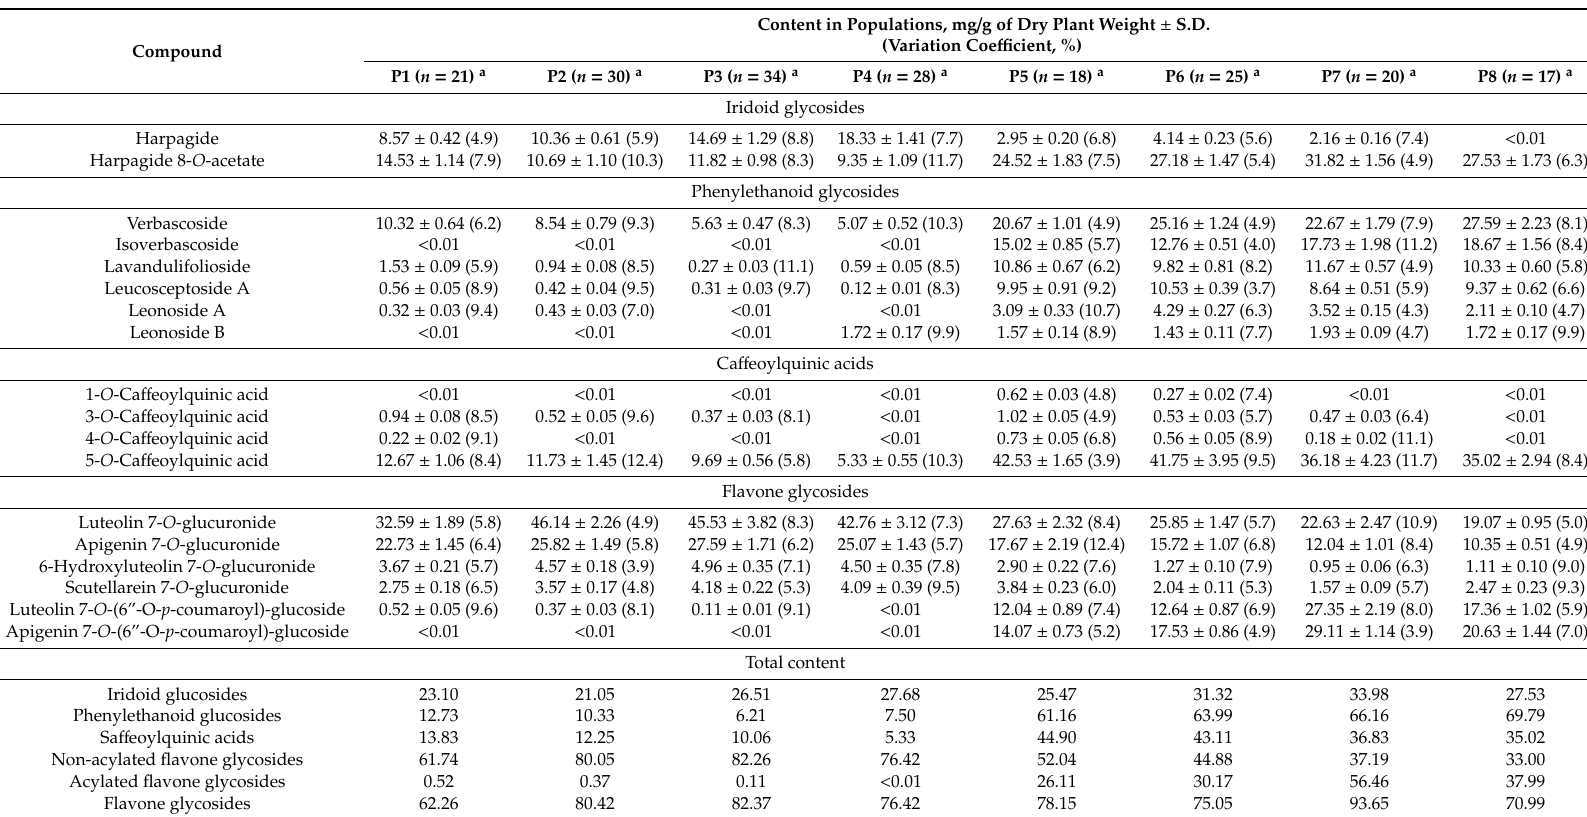
Table 4. Content of selected compounds in leaves of G. bifida from eight Siberian populations (P1–P8).